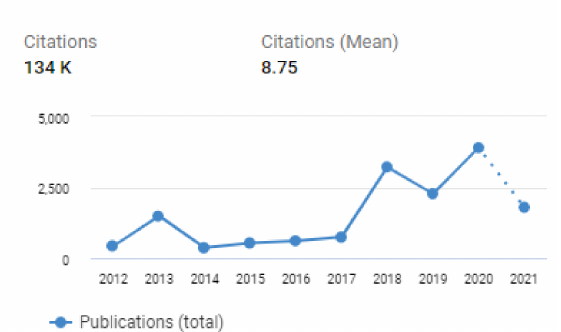
Figure 3. A plot of the number of articles as a function of year. This figure was generated using results from all 5 databases using search terms Diabetic Retinopathy AND (“Deep Learning” OR “Machine Learning”).